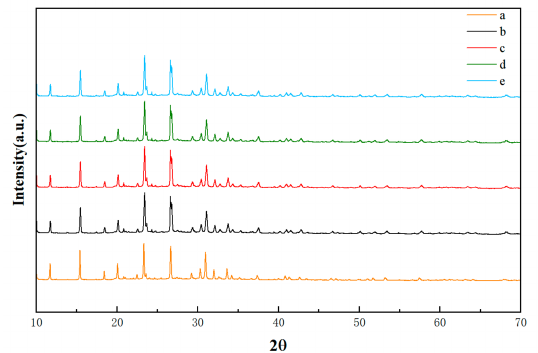
Figure 4. XRD patterns of blank 13X and modified 13X: (a) blank 13X, (b) ZnCl 2 -13X, (c) ZnAc 2 -13X, (d) Zn(NO 3 ) 2 -13X and (e) ZnSO 4 -13X,